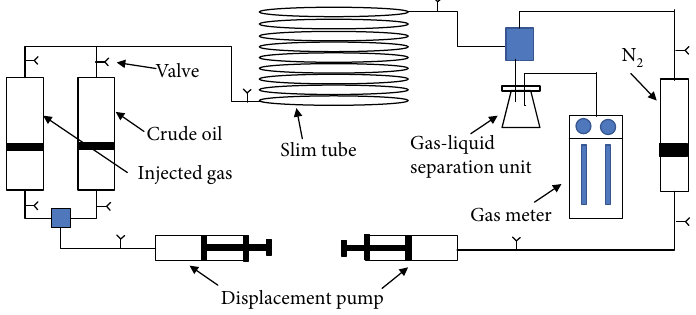
-crude oil system. 2